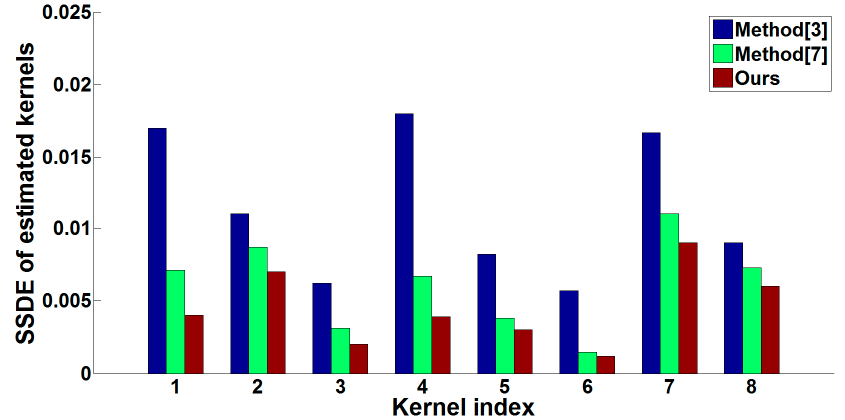
Figure 8. Comparison of the estimated kernels in terms of SSDE.